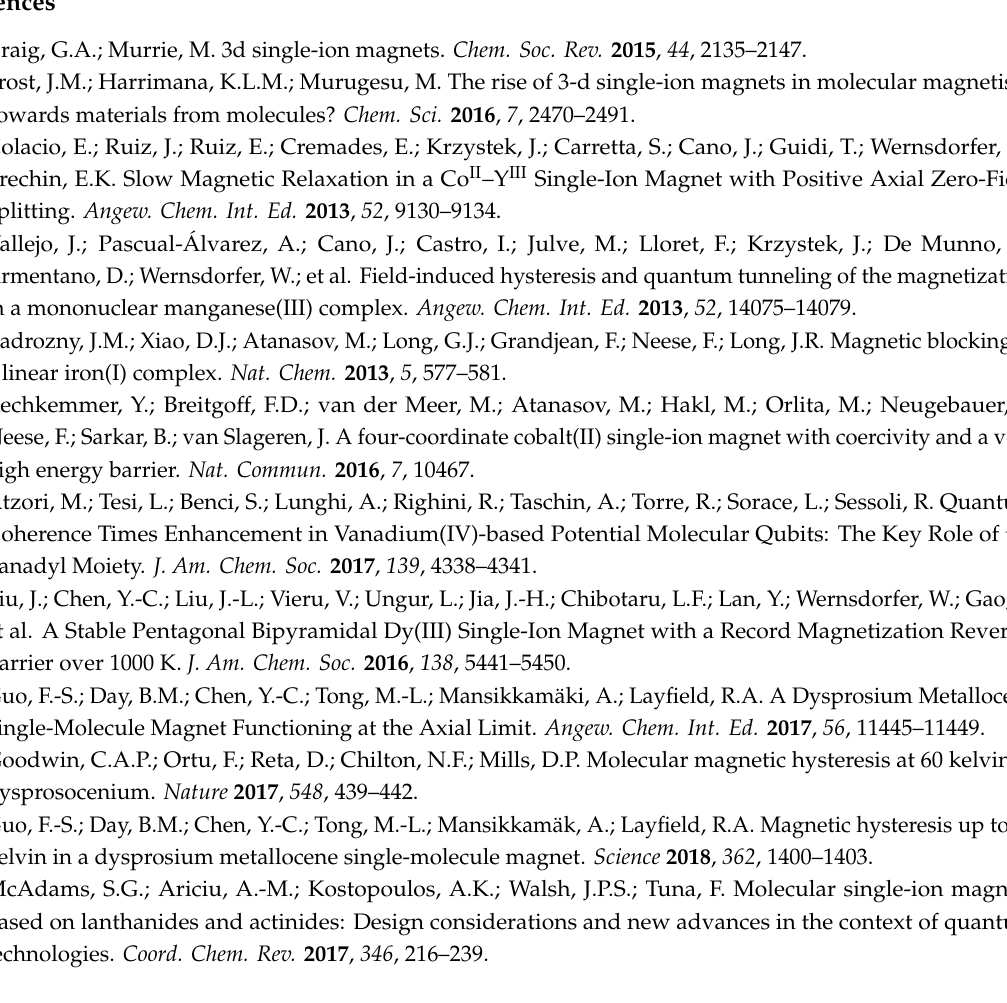
Figure S1: Sextuple phenyl embrace (SPE) supramolecular conformation of the PPh 4 + cations, Figure S2: Plots of the theoretical and experimental XRD patterns